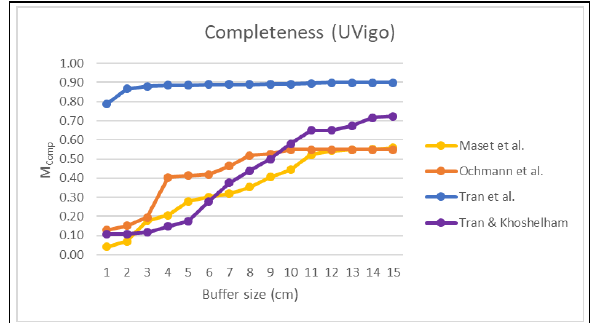
Figure 2. Completeness of submitted models for UVigo dataset.